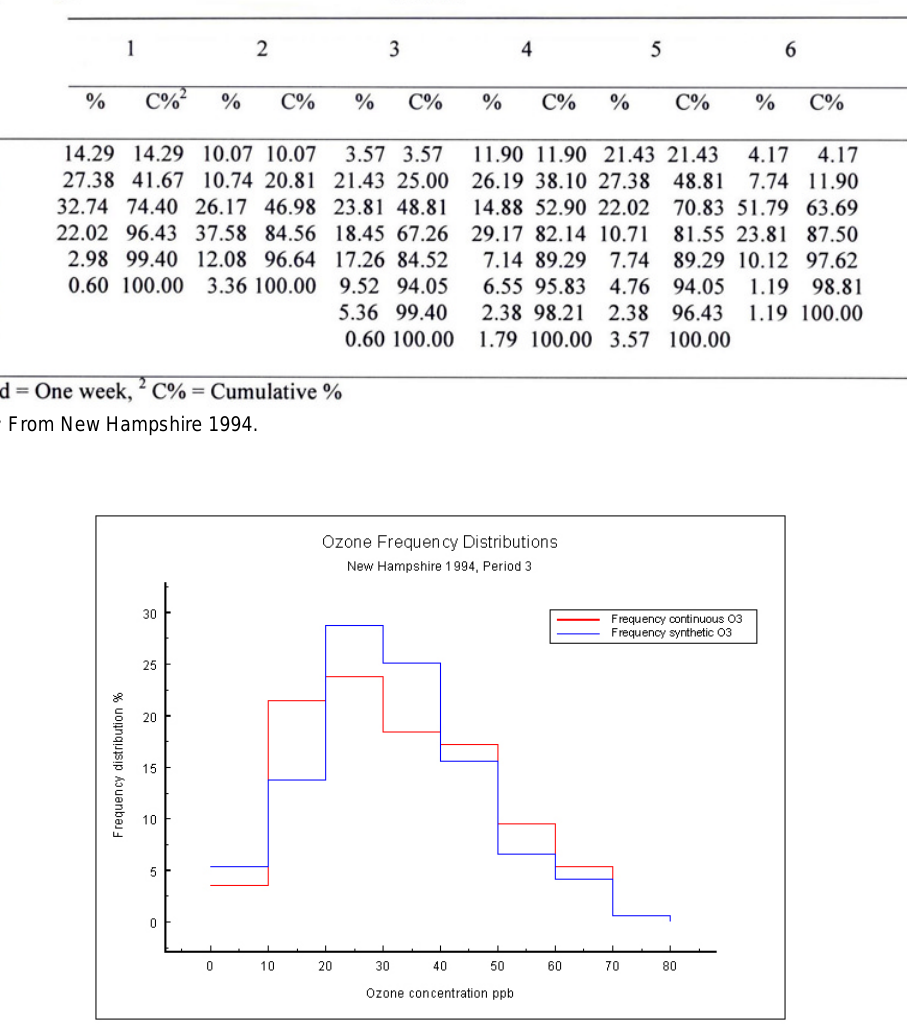
FIGURE 3. An example showing the relationships between the frequency distributions of hourly O 3 concentrations measured by continuous monitoring and synthetic data generated by the model. Mt. Washington, New Hampshire, July 19–26, 1994.